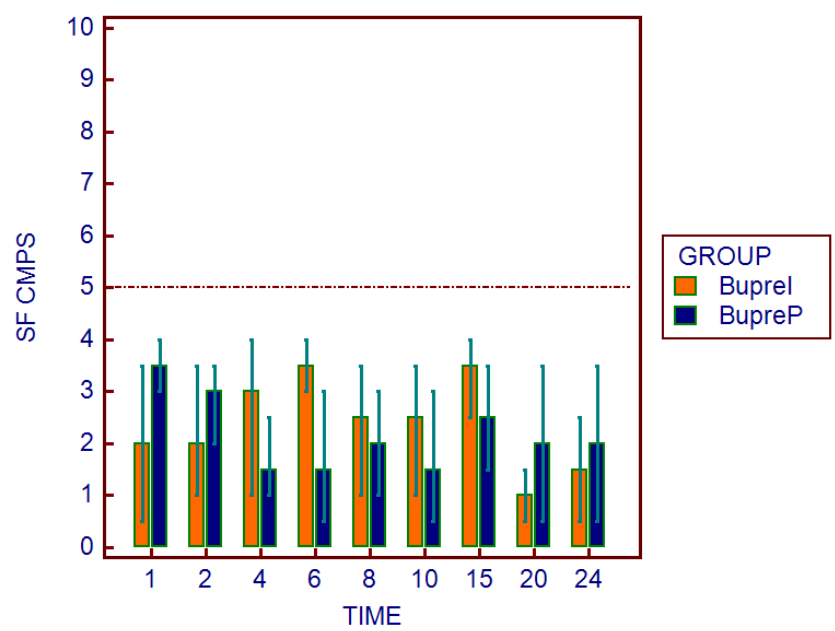
Figure 3. Graphical representation of the SF-CMPS scores in the two study groups at different times (1, 2, 4, 6, 8, 10, 15, 20, and 24 h after the extubation). The dotted line indicates the maximum score level above which dogs required supplemental analgesia.